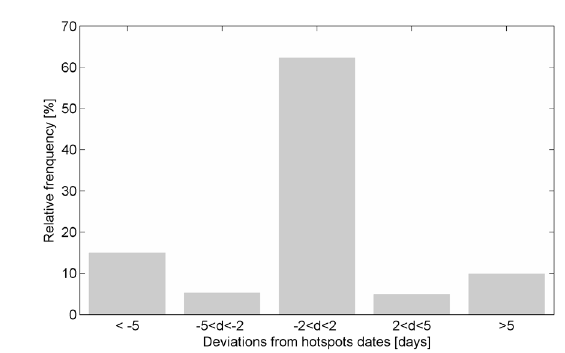
Figure 9 - Differences between dates assigned by the algorithm and MODIS hotspots dates.